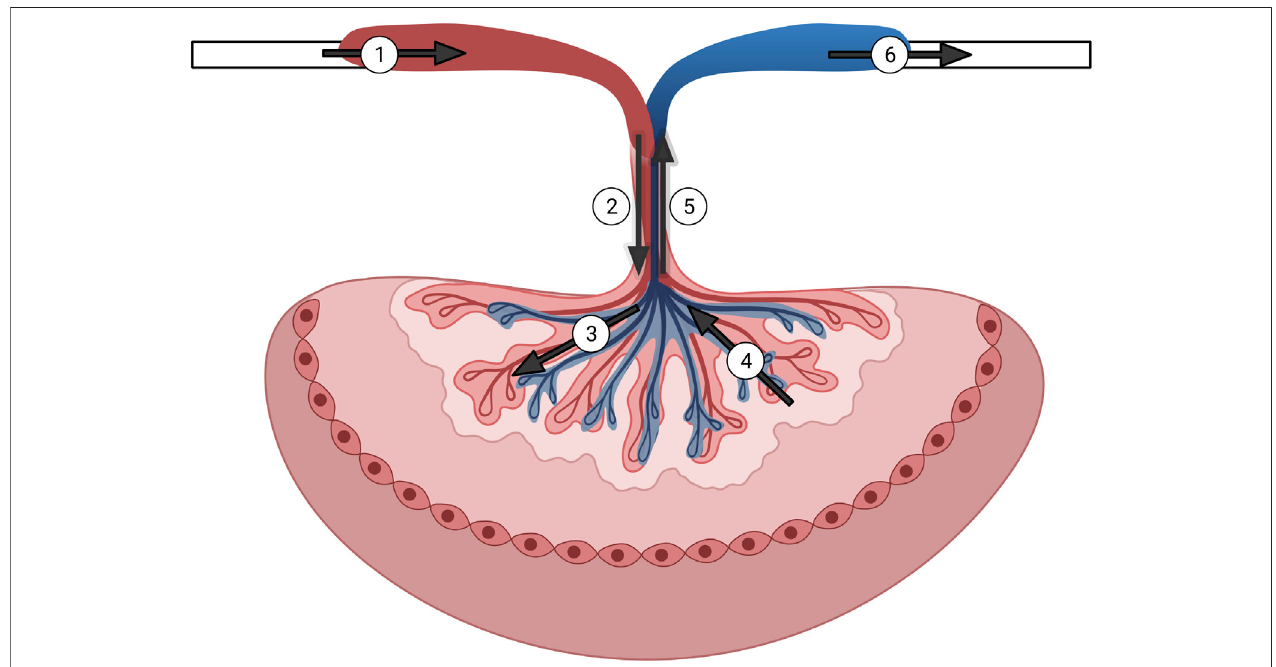
FIGURE7| Graphicalrepresentationoftheisolatedratplacentamodelandperfusionpathways.Numberinginthe fi gurerepresentsthefollowing:1)inputpressure pipette; 2) umbilical artery; 3) arteriolar waste delivery network; 4) venular nutrient network return; 5) umbilical vein; 6) output pressure pipette. Arrows show direction of the perfusate fl